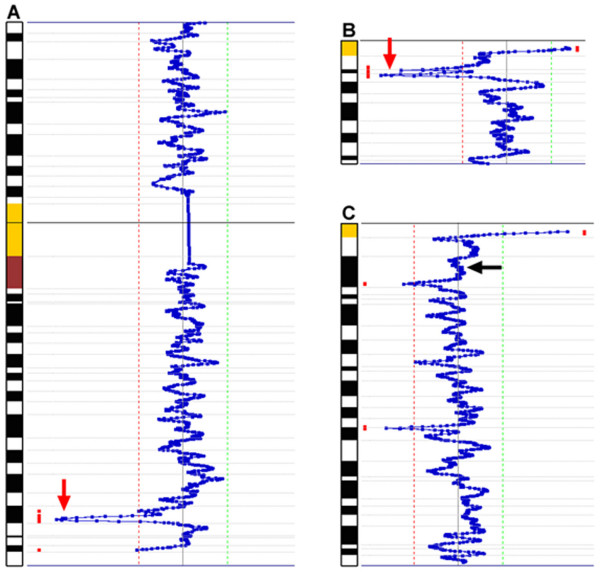
SMRT-array results showing the deletion on chromosomes 9 and 22 that are the result of the derivative 9 chromosome (der(9)) deletion in a chronic myeloid leukemia (CML) patient. The dotted red line denotes the 2 standard deviation cut-off to identify a deletion while the green dashed line marks the 2 standard deviation cut-off for a gain. A) Chromosome 9 alterations identified using the SMRT-array. The red arrow shows the deletion extending from 9q33.3 to 9q34.1. B) Chromosome 22. The deletion of chromosome 22 material, located around 22q11.2, on the der(9) chromosome is shown by the red arrow. C) Chromosome 14 from the same CML sample with the der(9) deletion, and shown to have the CNV14q12 event using another microarray comparative genomic hybridization platform as well as real-time polymerase chain reaction. The black arrow marks the site of CNV14q12 and, due to the use of a different normal genomic DNA sample, does not display the expected gain of genomic material. The most distal copy number variation was seen only in this sample and therefore not studied further.